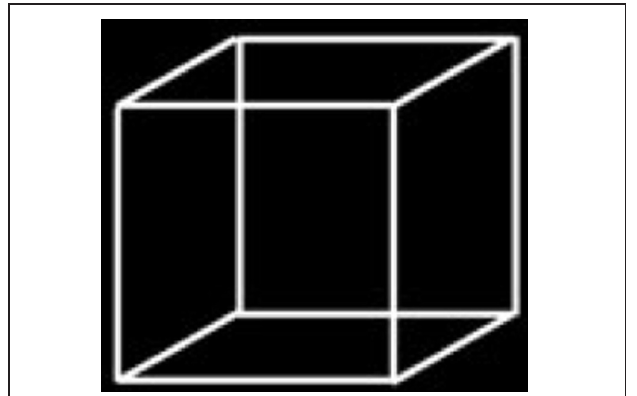
FIGURE 1 | Necker cube used as visual stimulus in our experiment. The stimulus was presented as a white line-drawing on a black ground. The visual angle of presentation was 5.0 ◦ . The stimulus was continuously presented for